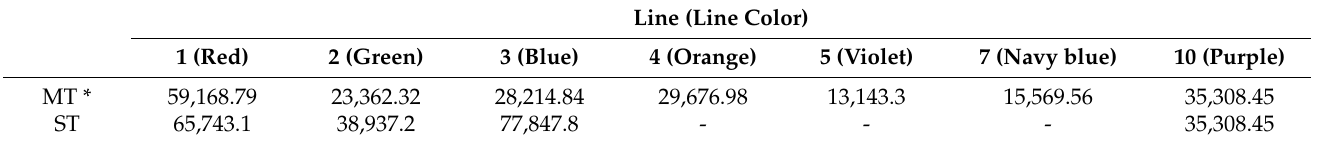
Table 14. Total energy consumption of all lines under scenario 3 (kwh).